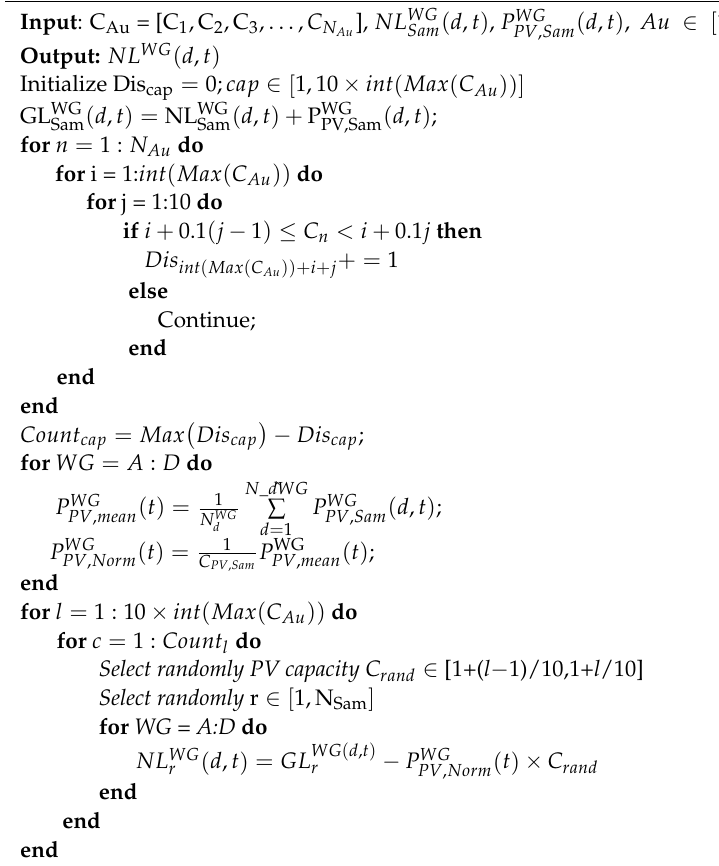
Algorithm 2. Generation virtual